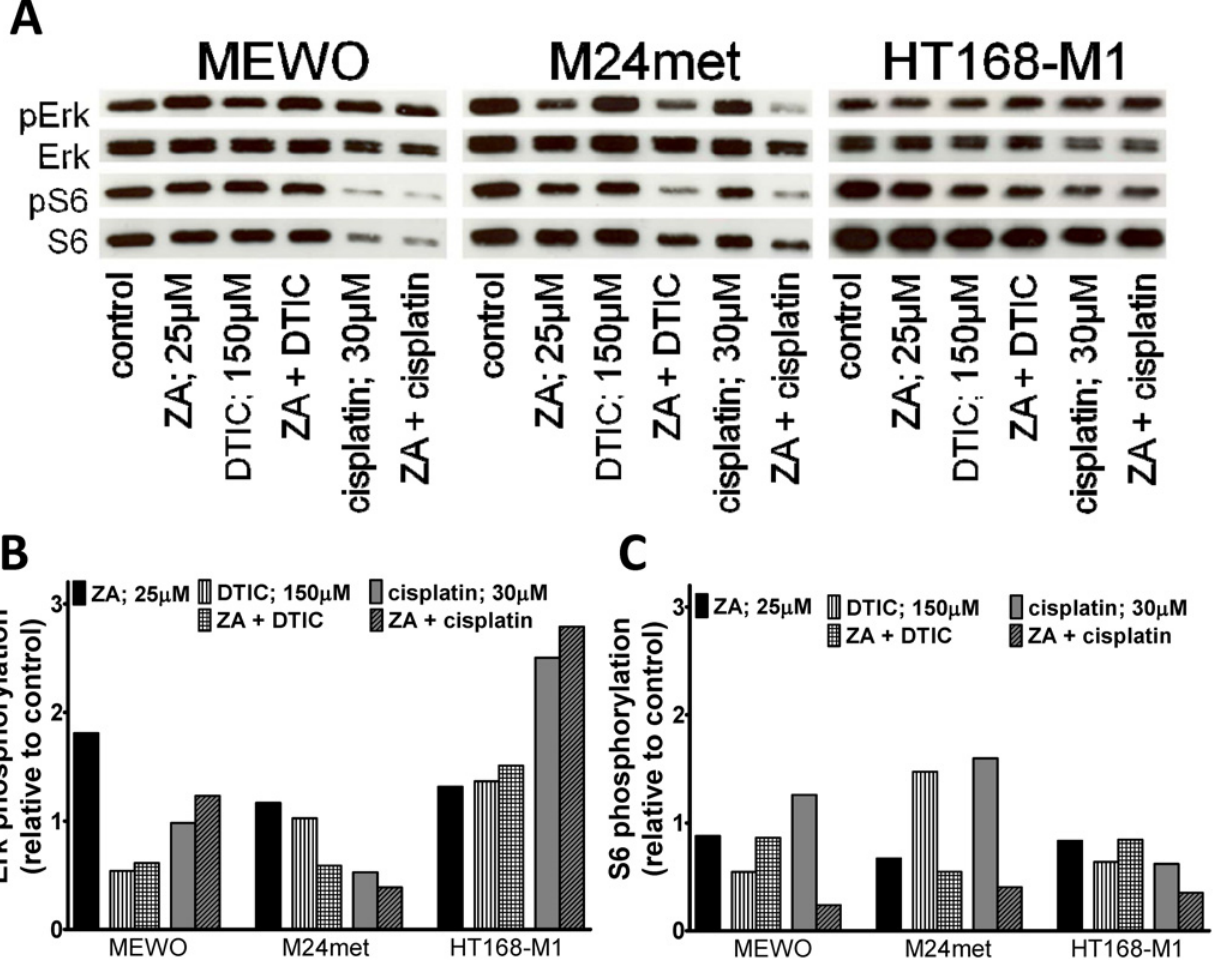
Fig 5. Activation of downstream elements of the RAS/RAF pathway in melanoma cells after combination treatments. ( A ) Representative blots of the effect of 12hs zoledronic acid (ZA) and/or DTIC/cisplatin treatment on the activation of Erk1/2 and S6. ( B ) Quantification of the effect of ZA and/or DTIC/ cisplatin treatment on the activation of Erk1/2. Treatment with cytotoxic agents decreased the activation of Erk1/2 in double wild type MEWO and NRAS mutant M24met cells. DTIC or cisplatin and combined treatment resulted in the increase of Erk1/2 activation in BRAF mutant HT168-M1 cells. ( C ) Quantification of the effect of ZA and or DTIC/cisplatin treatment on the activation of S6. DTIC or cisplatin treatment increased S6 activation in HT168-M1 cells. S6 activation was also increased in M24met and in the combination treatment with cisplatin also in MEWO cells. Synergism between ZA and cytotoxic treatment was seen only in M24met cells if treated with DTIC and ZA and MEWO cells after the treatment with cisplatin and ZA.